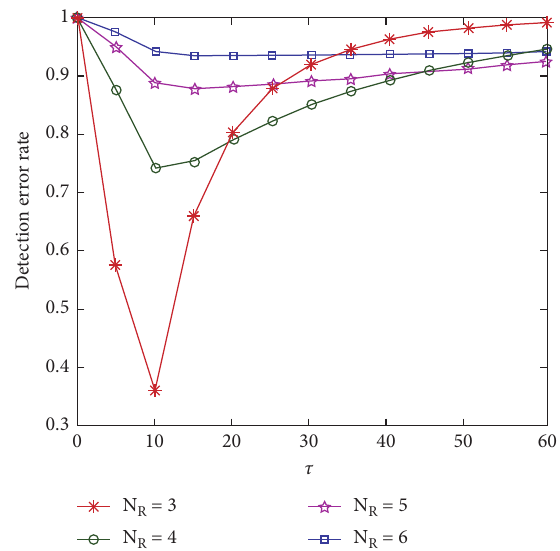
A with different � 0 dB , ϕ � 0 . 01, R